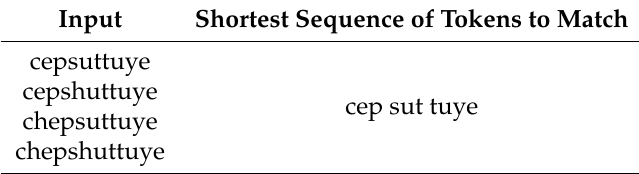
Table 3. A fragment of text before and after processing with the tokenization